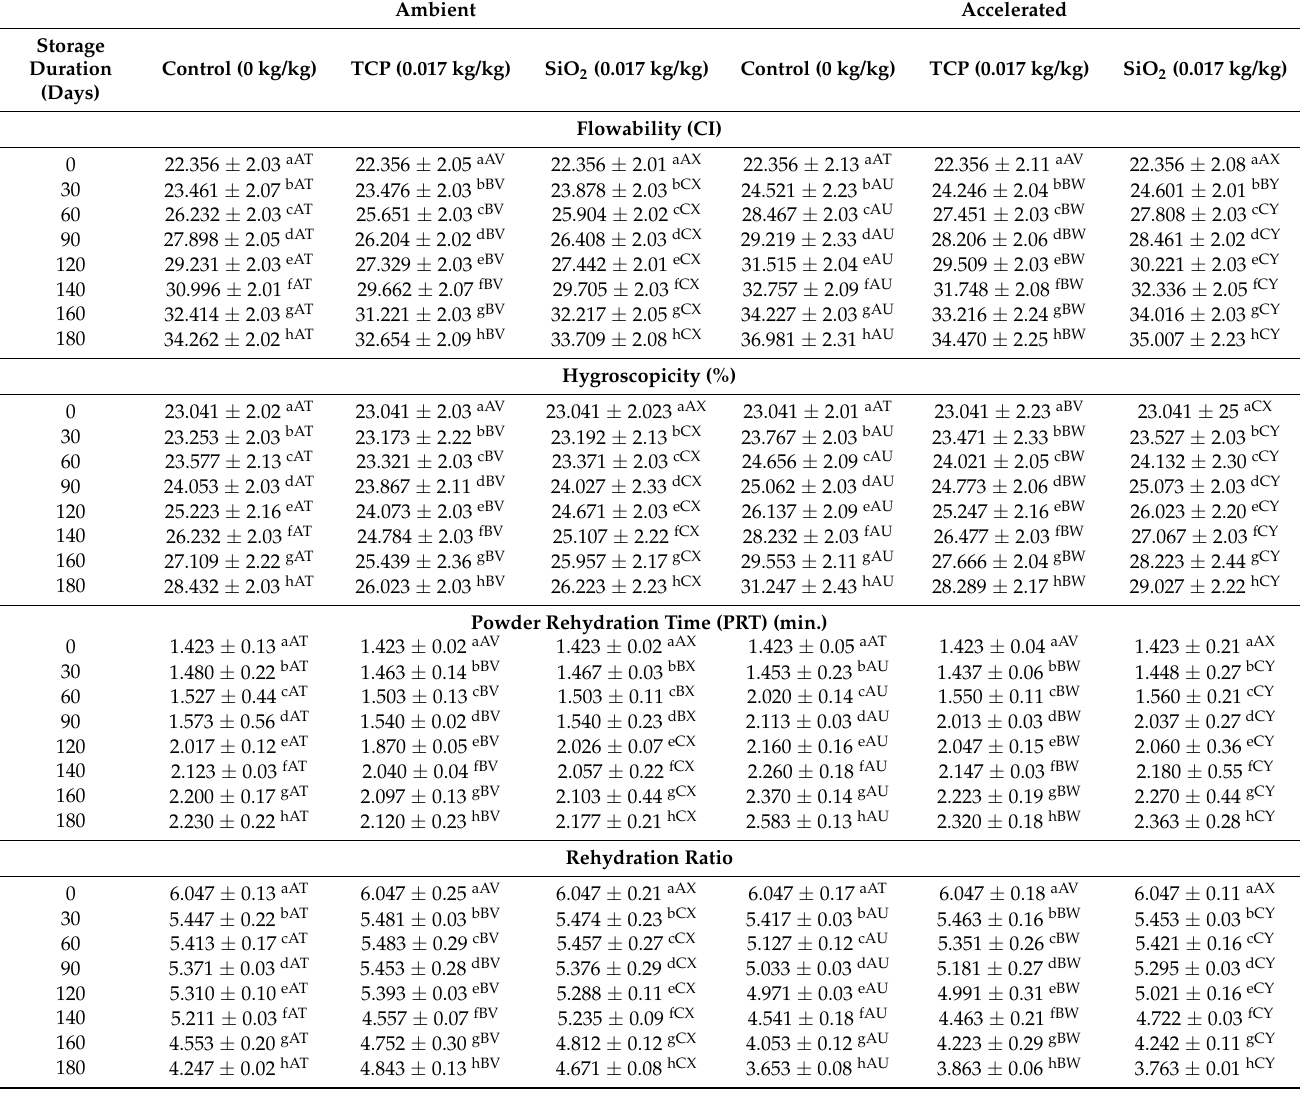
Table 2. Effect of storage duration, storage conditions (ambient and accelerated), and anticaking agents (TCP and SiO 2 ) on flowability, hygroscopicity, powder rehydration time, and rehydration ratio of spray-dried apricot powder